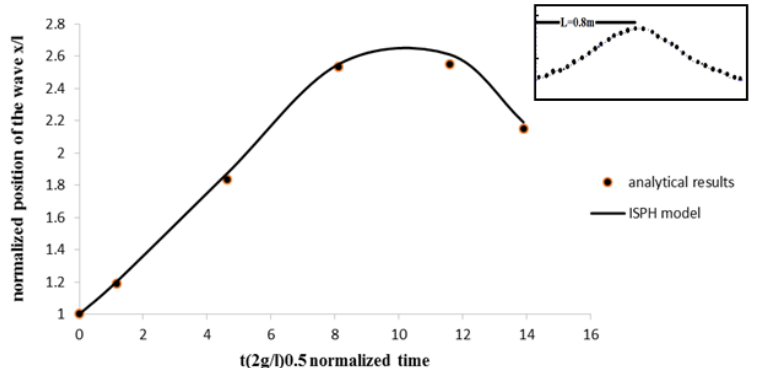
Figure 12 Normalized diagram of time compared to condition of the solitary wave front and its comparison with the analytical results for the solitary wave test case.